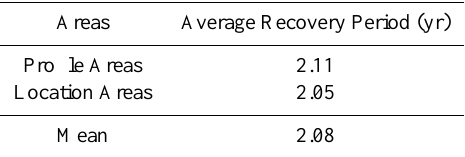
Table 4. Unrecovered profiles from the corresponding erosion event.